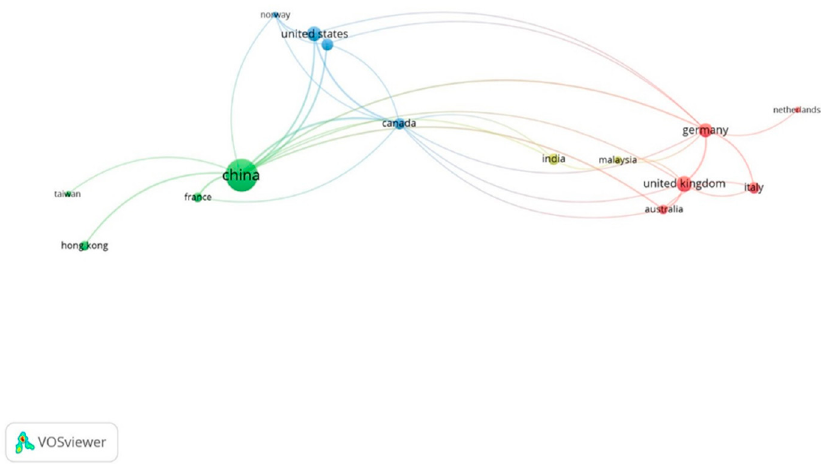
Figure 2. Co-authorship among countries (line 189).